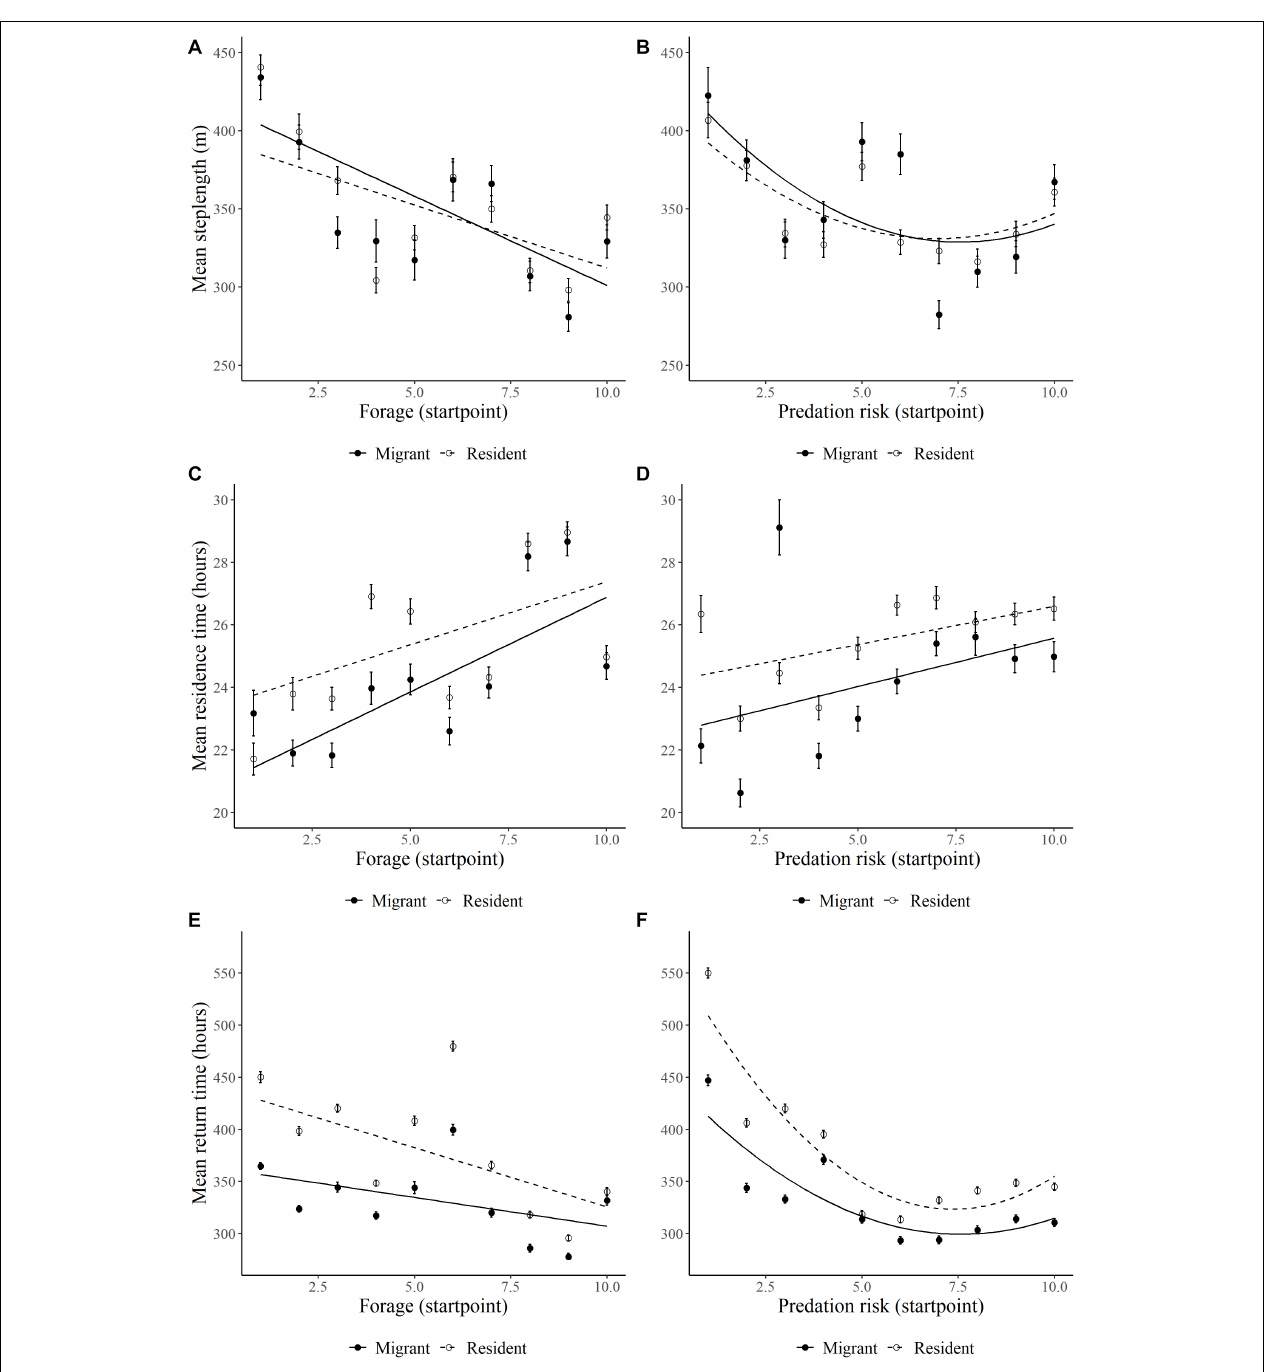
FIGURE 3 | Relationships between forage biomass and wolf predation risk and (A,B) mean diurnal step length (m), (C,D) residence time (hrs, 800-m radius), (E,F) and return time (hrs, 200-m radius, 48-h) of GPS-collared on Ya Ha Tinda winter range adjacent to Banff National Park, Alberta, Canada, during winters from 2002/2003 to 2015/2016. Forage biomass and wolf predation risk were measured at the initiation of a step (start point) and the relationship is graphed as to the means of 10 bins of the x -axis. Error bars show ± 1 standard error. Lines are best-fit models for migrant (solid circle/line) and resident (open circle/dotted line) elk. Supplementary Table S3 provides for model